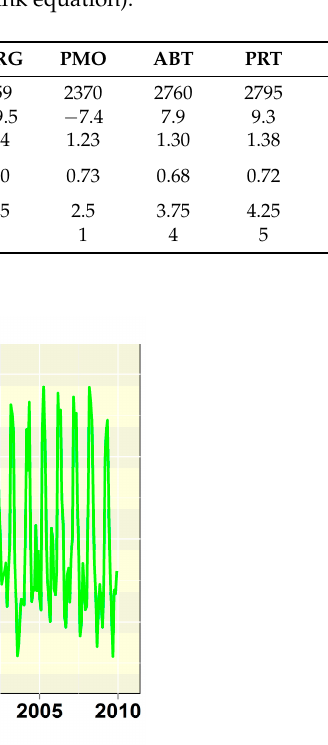
Table 1. Evapotranspiration Models comparison results from based on the statistical indicators (Where: OUD = Oudin evapotranspiration equation, HAM = Hamon method; TUR = Modified Turc method; HARG = Hargreaves method; PMO = Penman-Monteith combination equation; ABT = Simple Abtew equation; PRT = Priestley-Taylor method; MAK = Modified Makkink equation).